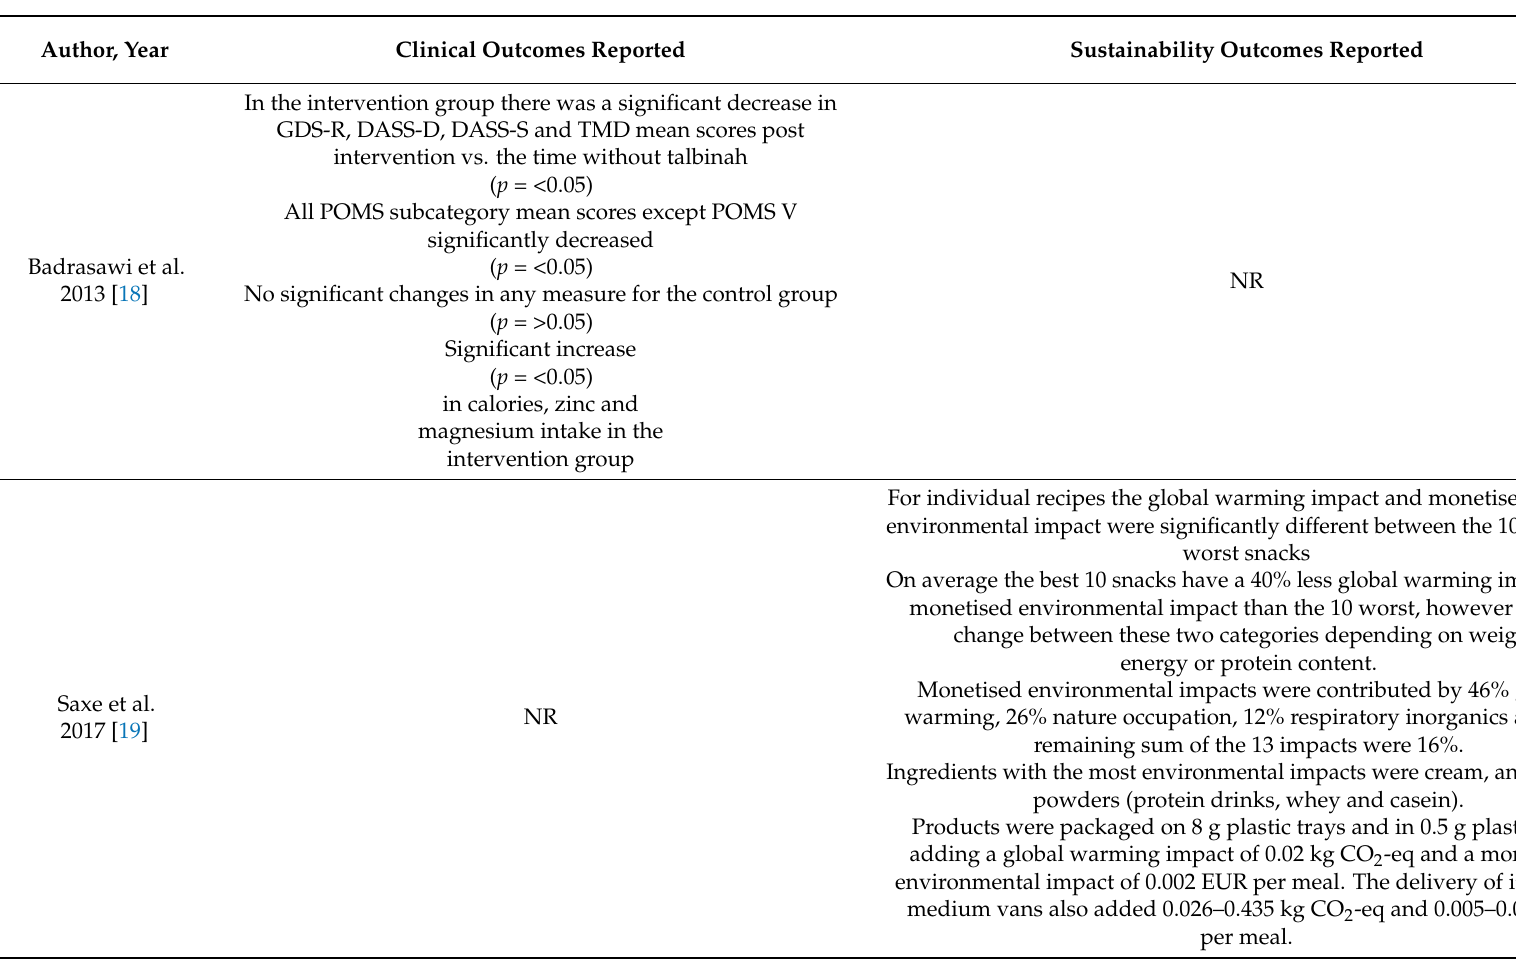
Table 3. Outcomes of innovative food and drinks implemented in health and aged